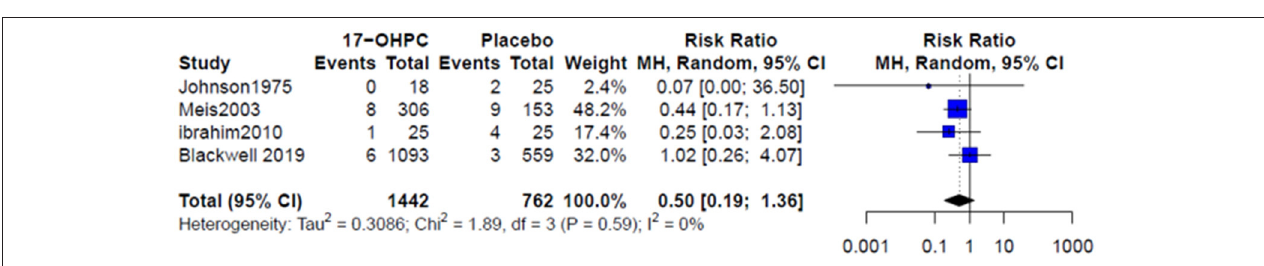
FIGURE 3 | Forest plots of the risk of neonatal